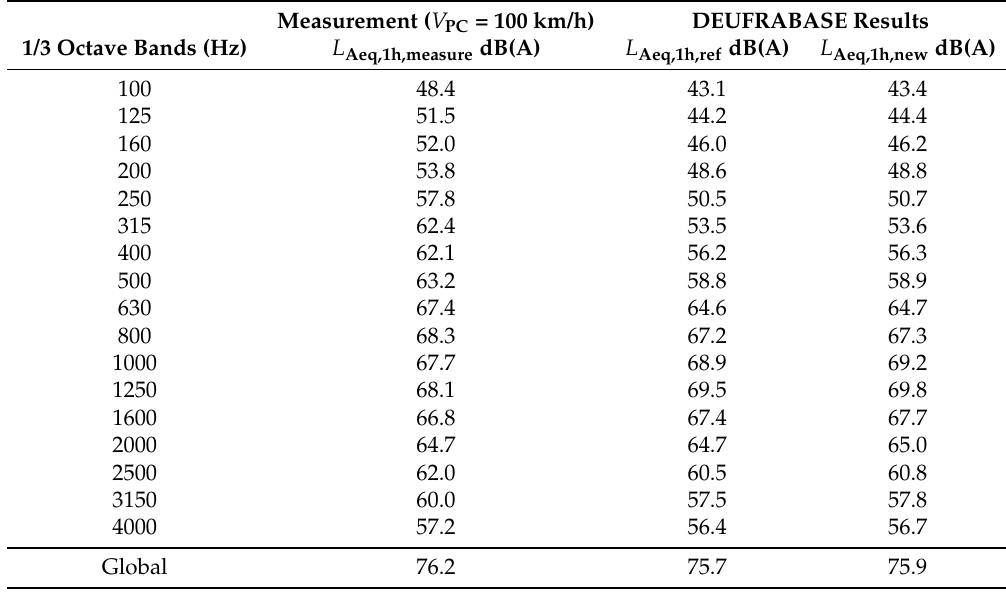
Table 6. Comparison of the data produced by the DEUFRABASE with measurements in the same road configuration. Since the measurements consider a PC traffic flow at 100 km/h, the DEUFRABASE results must be corrected from the reference speed of 90 km/h (ref) to 100 km/h